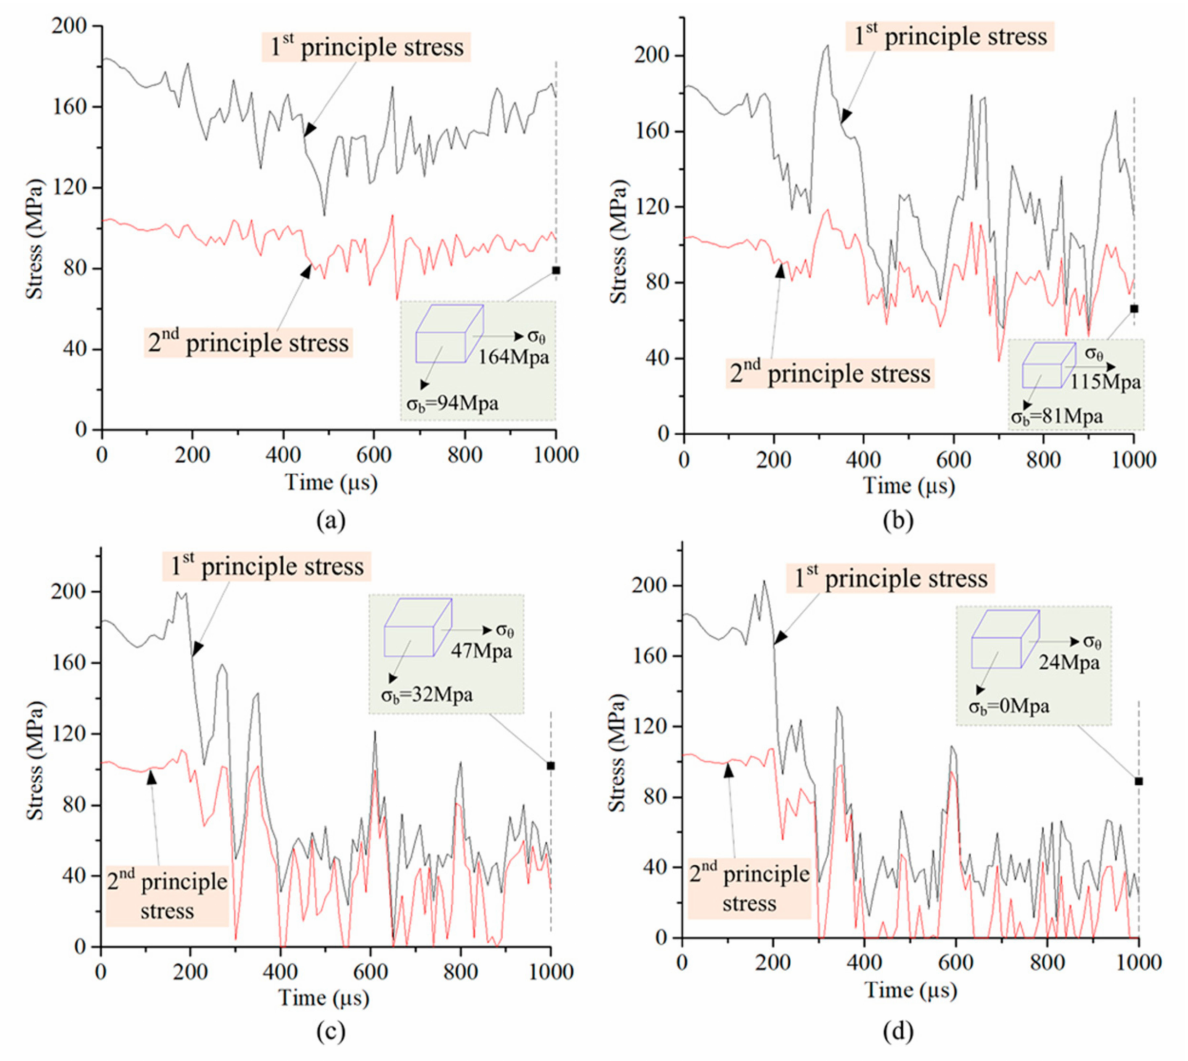
Figure 14. Principal stress vs. time after coil discharge for a discharge voltage of ( a ) 5 kV, ( b ) 6 kV, ( c ) 7 kV, and ( d ) 7.5